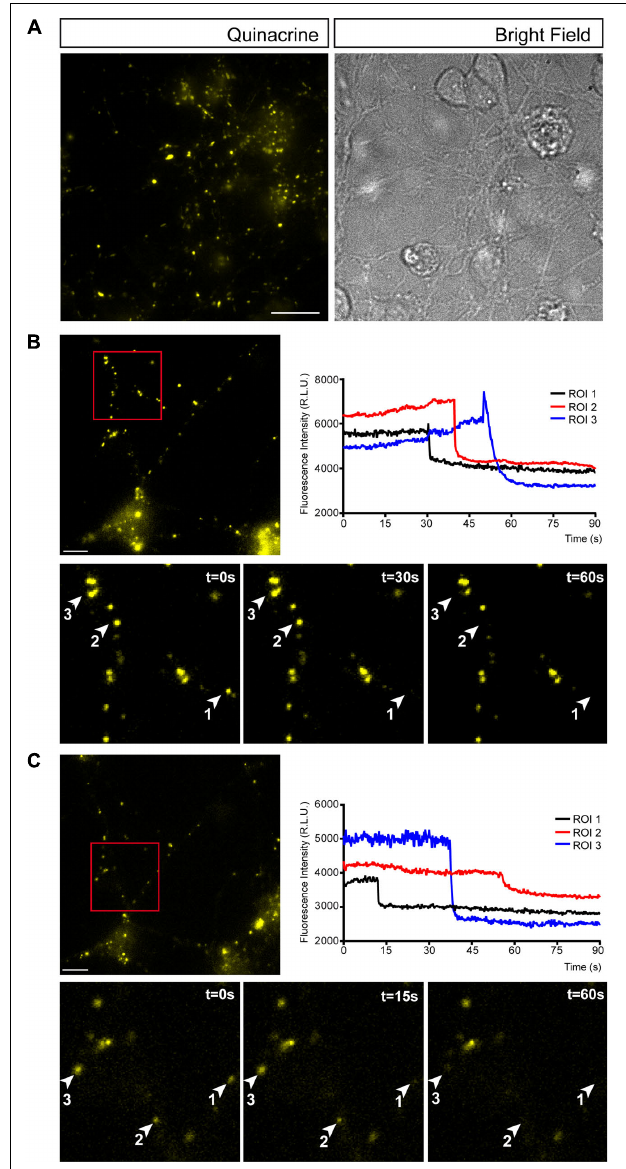
FIGURE 2 | Cerebellar granule cells release ATP through by exocytosis. (A) Representative micrographs of granule cells stained with quinacrine (pseudo colored in yellow). Bright field image of the same area is showed on the right. Vesicular ATP release after stimulation with 1 mm ATP (B) or 30 mM KCl (C) . In each panel, the upper image corresponds to the micrograph representing quinacrine staining before stimulation. Scale bar: 5 µ m. Insets represent sequential images of quinacrine-loaded vesicles showing the time course of the changes in fluorescence within a ROI during a 60 s stimulation with ATP (B) or KCl (C) . Graphical representation of the changes in fluorescence intensity corresponding to the selected ROIs during stimulation with ATP (B) or KCl (C)